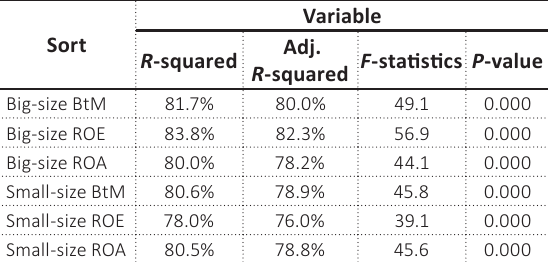
Table 3. Multiple linear regression results